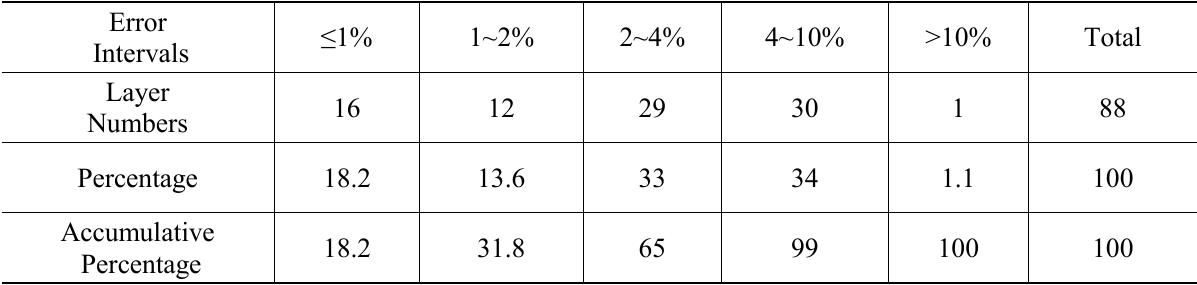
Figure 10—Recovery of layers calculated by the model and obtained by numerical simulation. Table 1—Comparison of water cut of layers calculated by the model and production